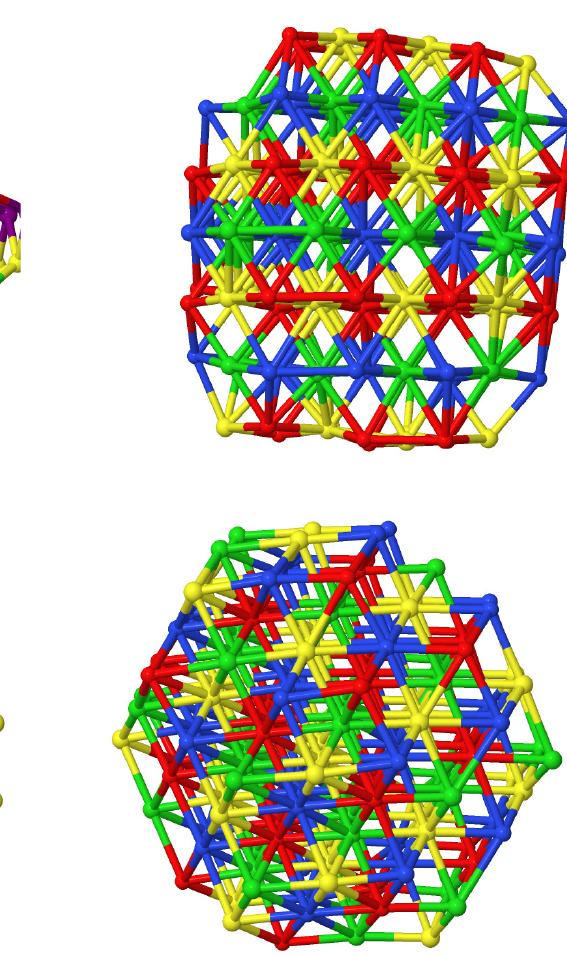
Figure 4: Additional lattice structures found for 0 < α = β < 1 and for β = 0. Top left: A sample of hexagonal lattice from a simulation with 3000 instantons at α = β = 0.4. Top right: A sample of a (nearly) bcc lattice from a simulation with 3000 instantons at α = β = 0.07. Bottom left: A sample of a lattice with hexago- nal antiferromagnetic layers from a simulation with 5000 instantons at α = 10 and β = 10. Bottom right: A sample of a bcc lattice (with nonstandard orientation struc- ture) from a simulation with 5000 instantons at α = 0.6 and β =